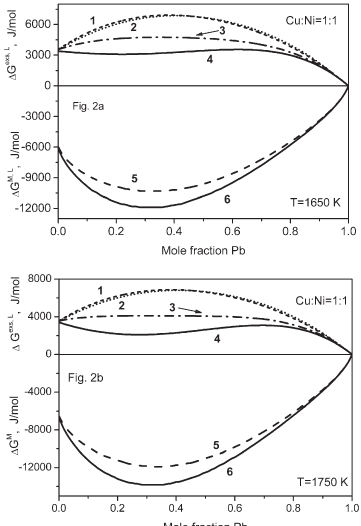
Figure 2. Integral molar Gibbs excess energies ( ∆ G exs,L , J mol -1 ) of the ternary liquid phase calculated (at 1650 K and 1750 K, respectively) along a section with constant molar Cu/Ni ratio equal to 1/1. Curve 1 is calculated using binary optimizations of COST 531 thermodynamic database [1], curve 2 – using GSM [22], curve 3 – ternary optimization of Wang et al . [24], curve 4 – this work. Curve nos. 5 and 6 compare the integral molar Gibbs energy ∆ G M,L , J mol -1 (referred to the liquid state) assessed using ternary optimized parameters of Wang et al . [24] and this work, respectively.